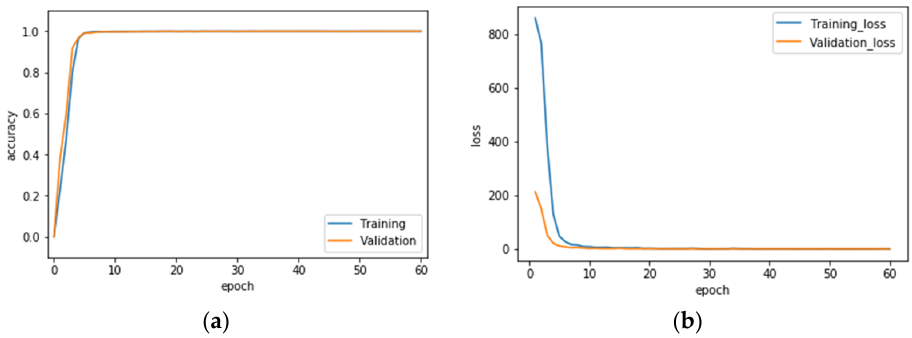
Figure 20. Recognition rate ( a ) and loss value ( b ) curves of the VGG-16 CNN model training using min-max wavelet fused images.